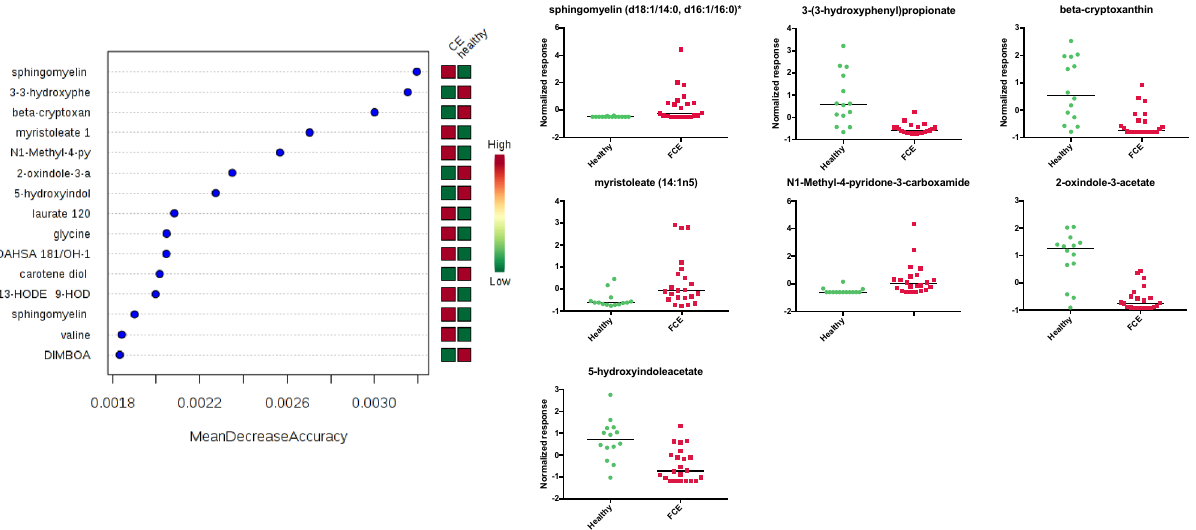
Figure 2. Random Forest variable importance plot and scatter plots of the top seven metabolites with the highest importance for the model accuracy. ( a ) Random Forest variable importance plot. Random Forest is a supervised, machine learning algorithm used for regression (prediction) and classification analysis of large data sets. This Random Forest algorithm was based on the comparison of cats with chronic enteropathy (FCE) and healthy control cats. The model identifies features with the highest predictive accuracy for health status. The variable importance plots shows the significant features identified by Random Forest. The features are ranked by the mean decrease in classification accuracy when they are permuted. A higher value indicates the importance of that metabolite in predicting the group (healthy vs. chronic enteropathy). Data was mean centered and divided by the standard deviation of each variable (autoscaled). ( b ) Scatterplots of the top seven metabolites from ( a